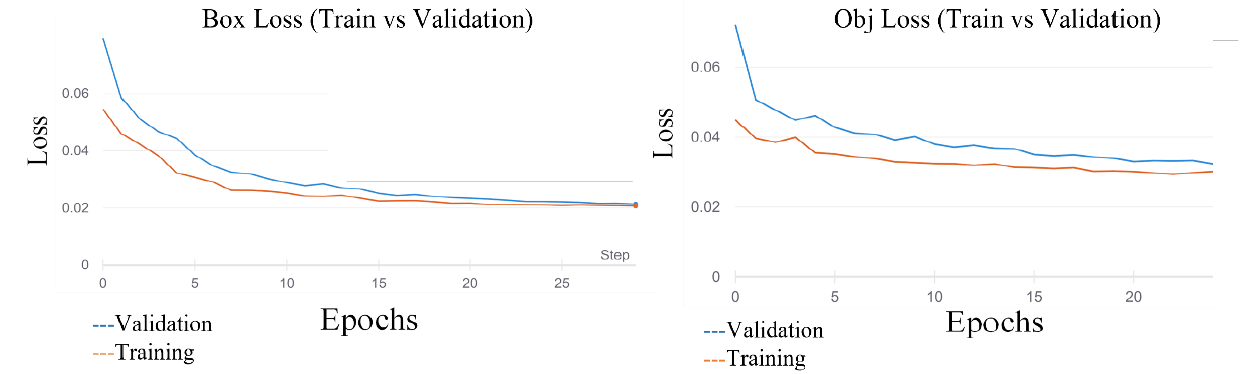
Figure 3. The training and validation loss of YOLO v5 on the cattle dataset.